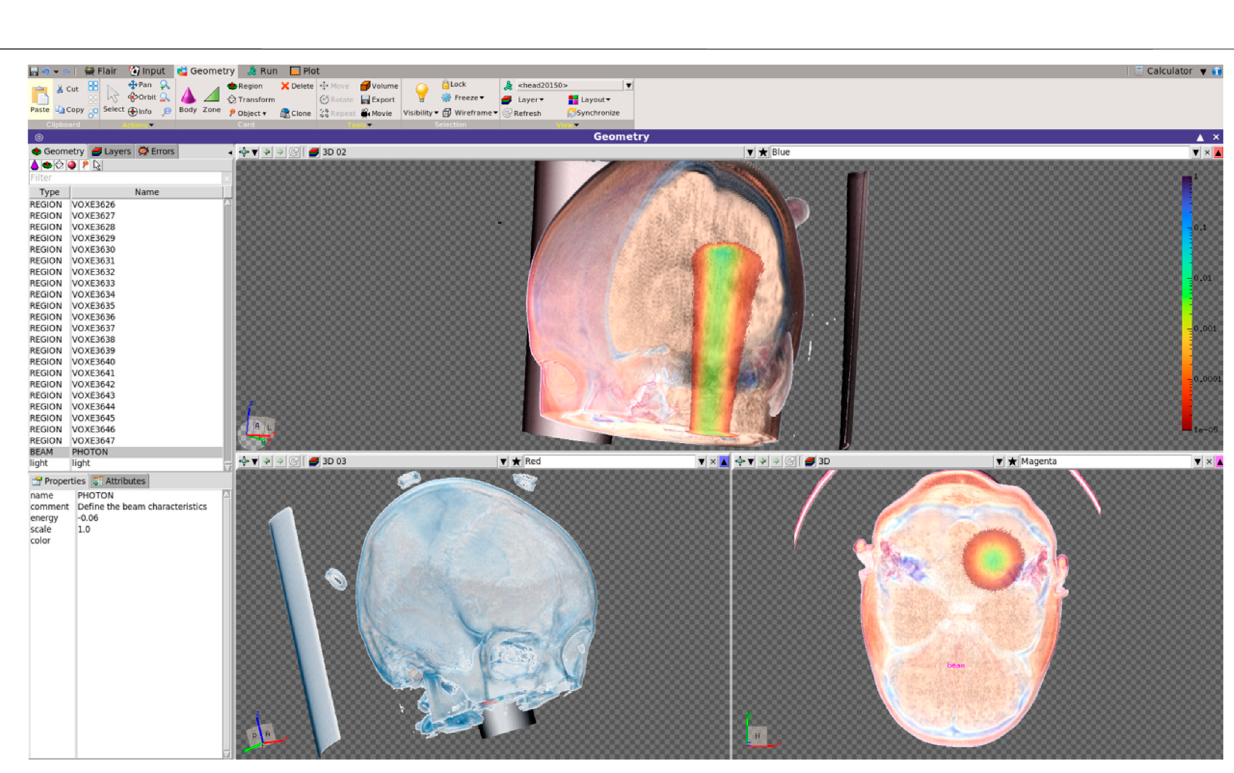
Frontiers in Physics |